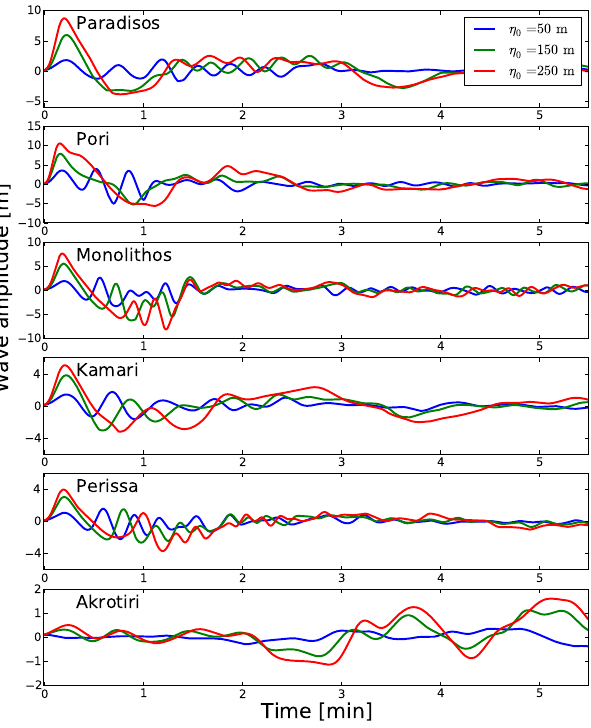
Fig. 8. Water surface displacement registered near six coastal towns along Santorini (cf. Fig. 2 for map) and for three different explo- sion powers. Time signals are shifted so that zero time corresponds to arrival time for a given simulation. Gauges are positioned 400m, 900m, 500m, 500m, 800m and 450m off Paradisos, Pori, Mono- lithos, Kamari, Perissa and Akrotiri. Note, that the vertical scale is different for each